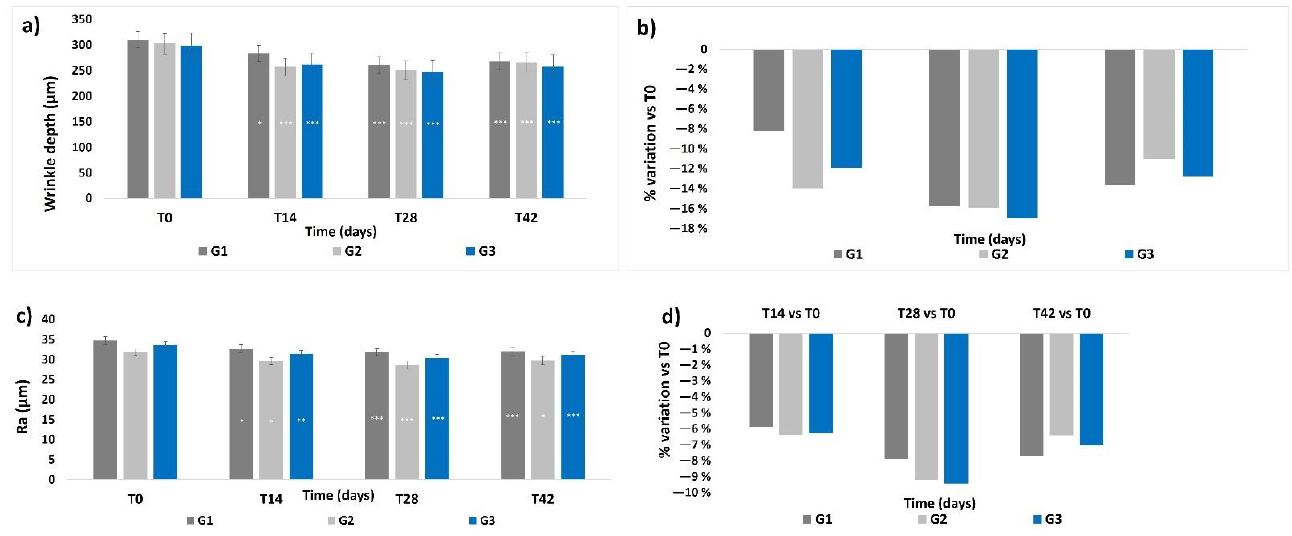
Figure 6. Skin profilometry. The graphs show data obtained at each monitored time for the three groups. ( a ) Wrinkle depth. Data are expressed in μm (mean ± SEM). ( b ) Wrinkle depth. Data are reported as mean percentage variation with respect to values at T0. ( c ) Skin smoothness. Data are expressed as mean ± SEM of the Ra parameter (μm). ( d ) Skin smoothness. Data are reported as mean percentage variation with respect to values at T0. Legend = *** p < 0.001 vs. T0, ** p < 0.01 vs. T0, * p < 0.05 vs. T0.